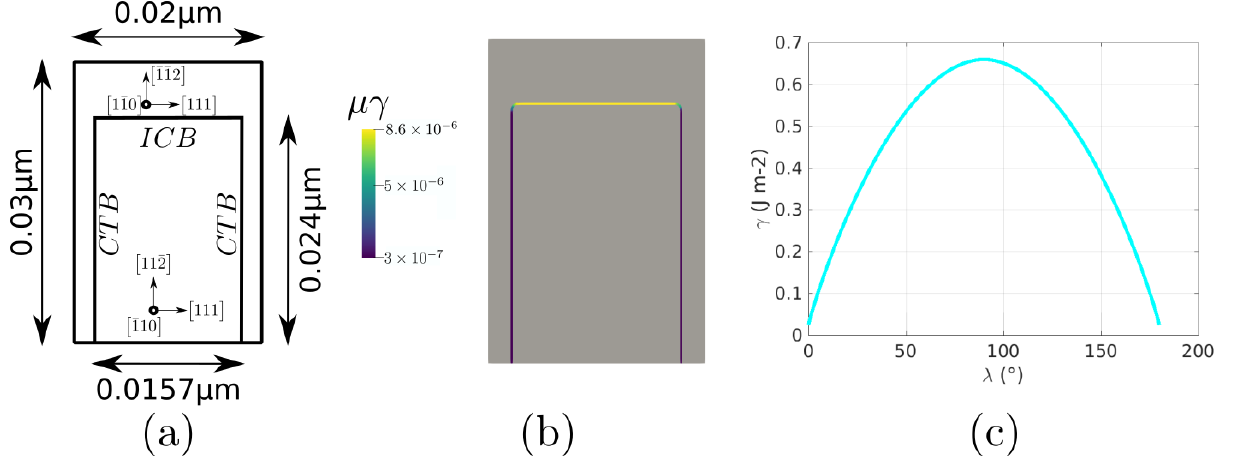
Figure 22. ( a ) Grain orientations, ( b ) initial reduced mobility [ µ m 2 /s], ( c ) change of GB energy as a function of the GB inclination, λ , with respect to the x-axis, evaluated using the GB5DOF